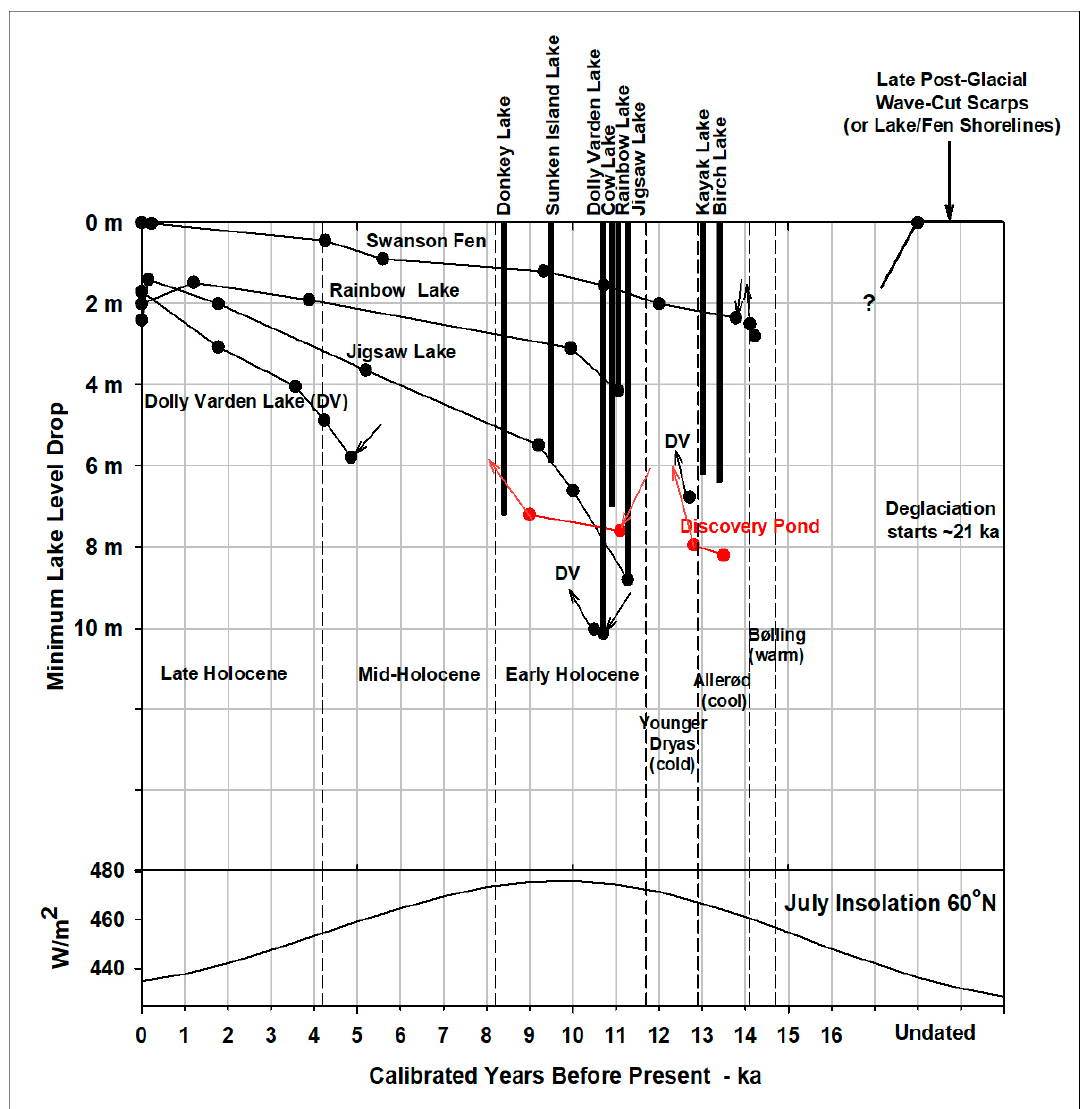
Figure 12. Summary chronology of central Kenai postglacial lake level variation. Lake level drops are measured below wave-cut scarps, which are typically several meters above modern lake levels. Lake level heights are estimated with respect to modern shorelines for Discovery Pond [9] and Swanson Fen [17], with the 12 ka date adjusted from 11.3 ka, following [9]. Discovery Pond is shown in red for clarity. Climate periods follow [59,60]. July insolation for 60° N is from [61]. Black dots show radiocarbon dates; arrows show fall or rise of lake level. The label “DV” shows peat segments of the Dolly Varden core which are separated by gyttja.